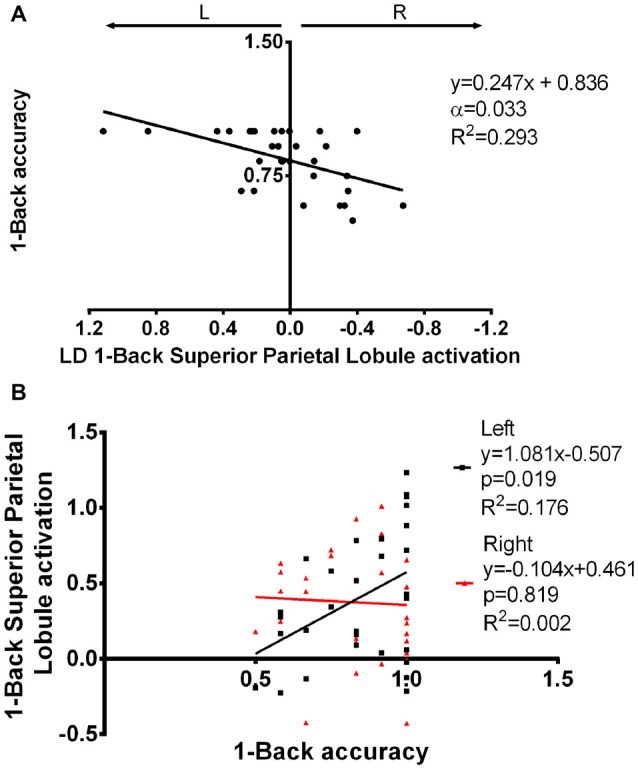
Superior parietal lobule’s LD in association with 1-Back accuracy. (A) Superior parietal lobule’s LD was positively correlated with 1-Back accuracy, i.e., increased left to right difference was associated with better performance. (B) The association seen in (A) seems to be mainly due to a positive correlation between left superior parietal lobule activation and task performance. LD, laterality degree; α, Bonferroni corrected p-value.